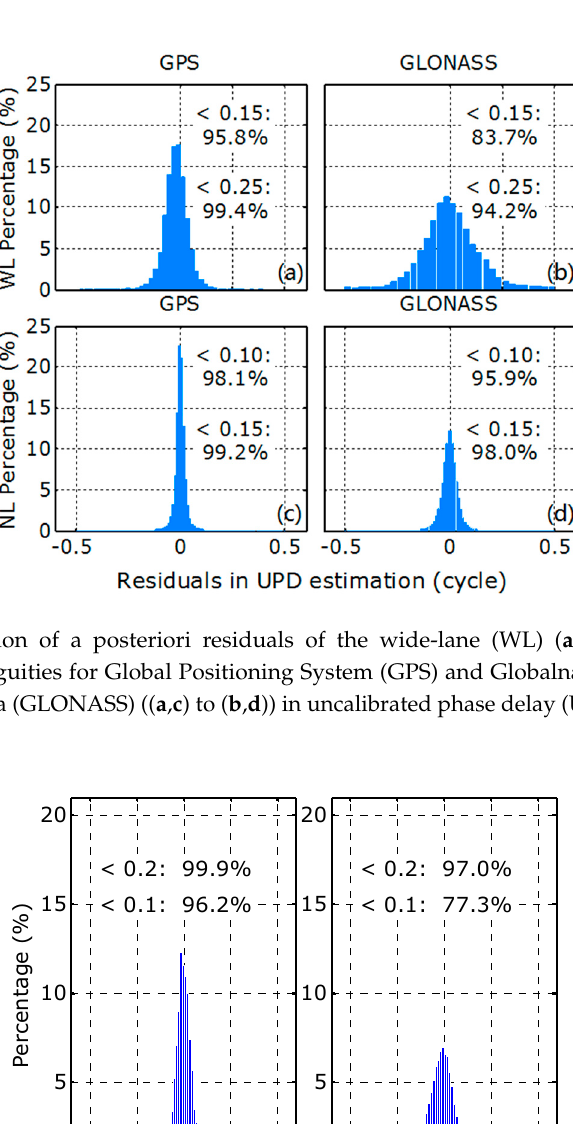
Figure 5. Stability of daily WL IFCB estimates of all 24 GLONASS satellites for four representative stations. Different color represents different satellites. Outliers correspond to there being no IFCB estimate for this satellite on this day. To further validate the quality of the IFCB corrections, we processed GPS + GLONASS daily static PPP-IAR for each rover station. We attempted to fix ambiguities with a tracking arc longer than 30 min by rounding with the criterion of 0.2 cycles. Figure 6 shows the average daily fixing percentage for each station. For all stations, the fixing percentage is over 97.1% and 95.3% for the GPS and GLONASS, respectively, with averages 99.4% and 98.9%. Upon applying the IFCB corrections, the